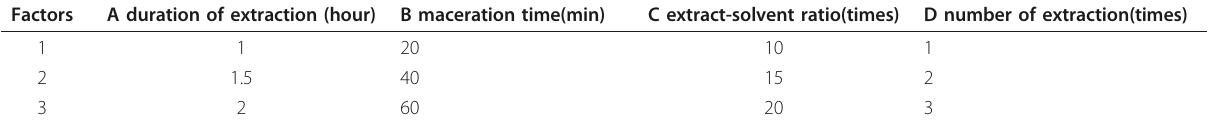
Table 1 The orthogonal test of four factors at three different levels Factors A duration of extraction (hour) B maceration